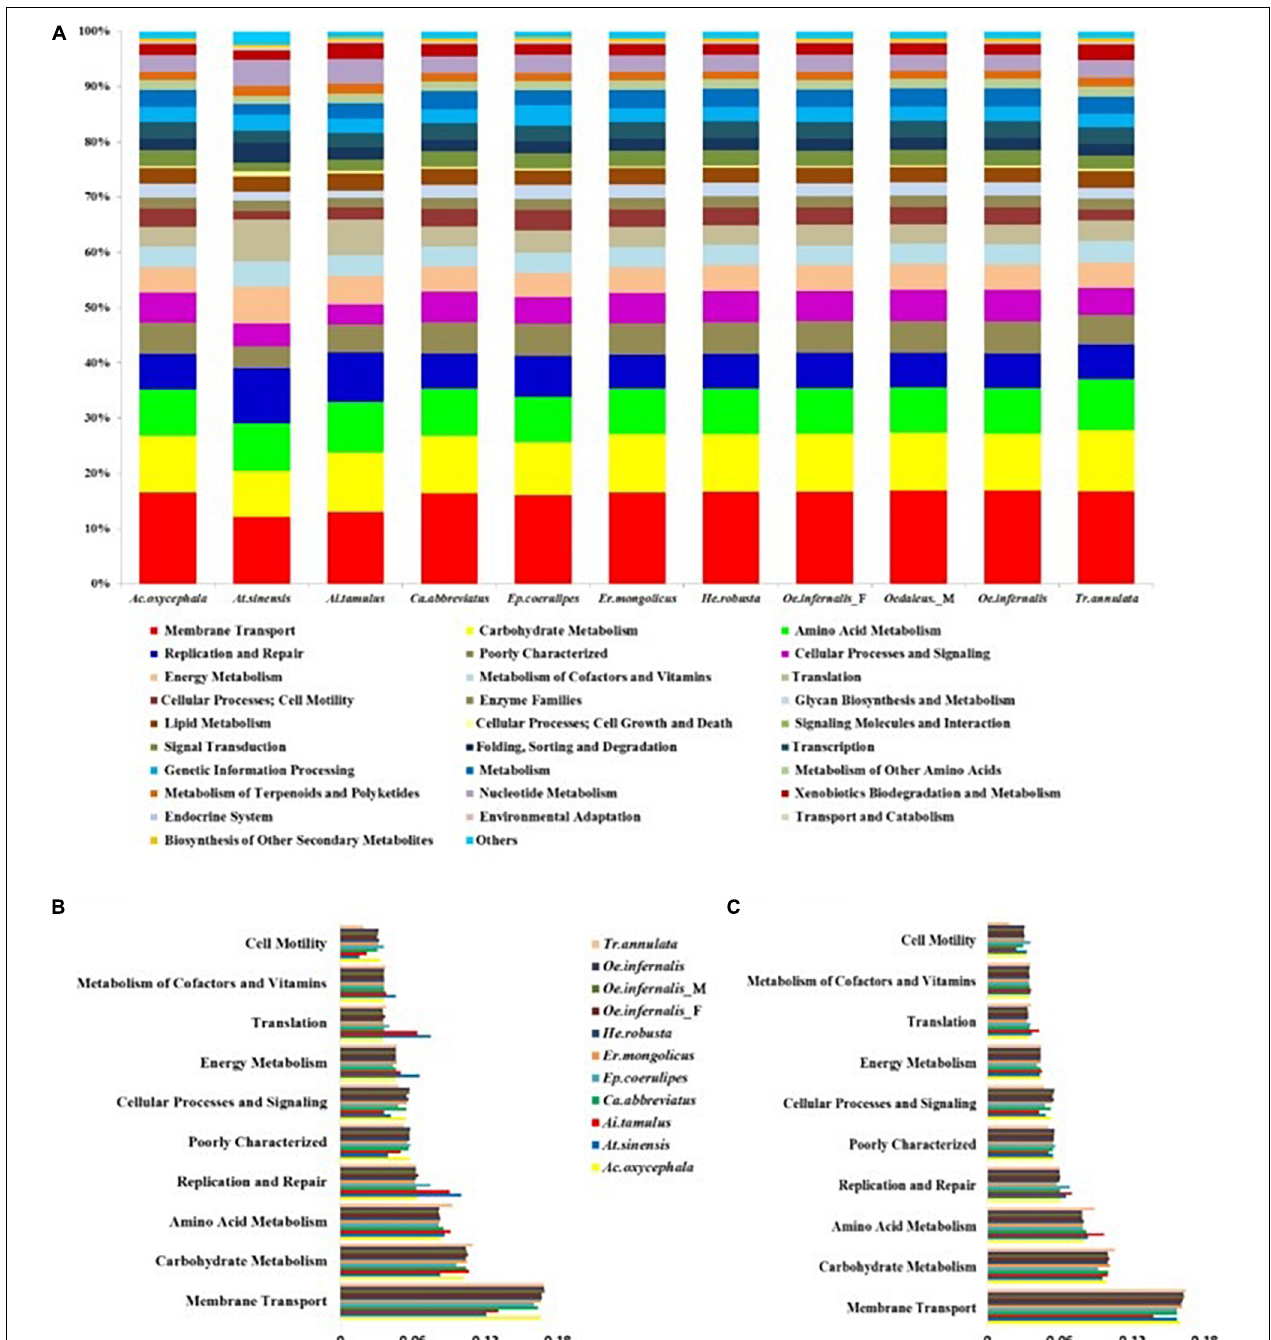
FIGURE 4 | The predicted functions of gut bacteria in grasshoppers using PICRUSt. (A) Functional prediction of gut bacteria in all grasshoppers. (B) Histogram showing the 10 dominant KEGG pathways of the common 18 OTUs. (C) Histogram showing the 10 dominant KEGG pathways of gut bacteria in all